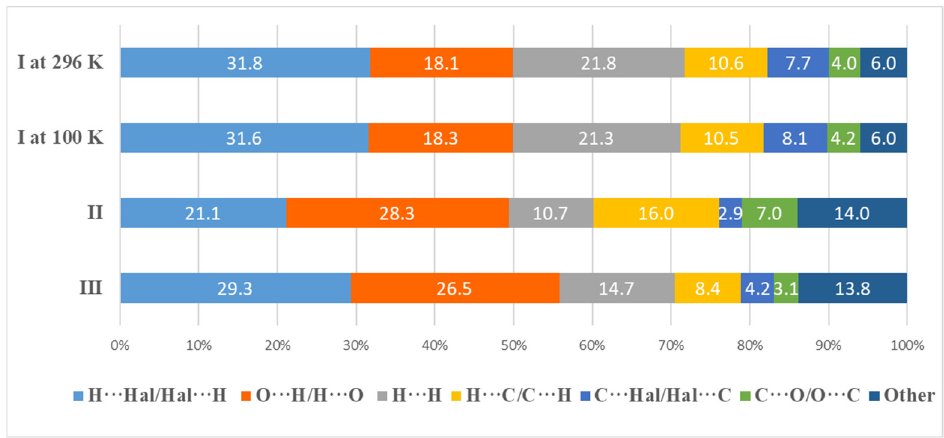
Figure 7. Percentage contributions to the Hirshfeld surface area for the various close intermolecular contacts for cations in I - III .